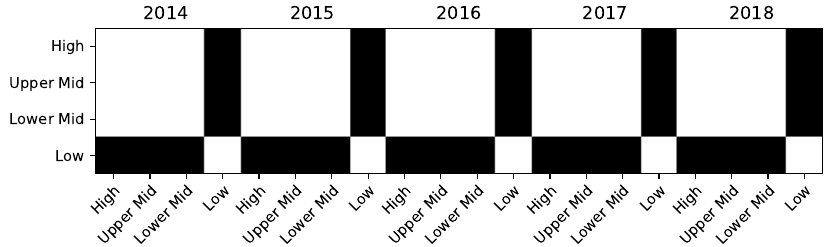
Figure 8. A heatmap of the results of all pairwise Kolmogorov–Smirnov tests. Black cells indicate where we reject the null hypothesis that two income groups form international collaborations in similar manners.